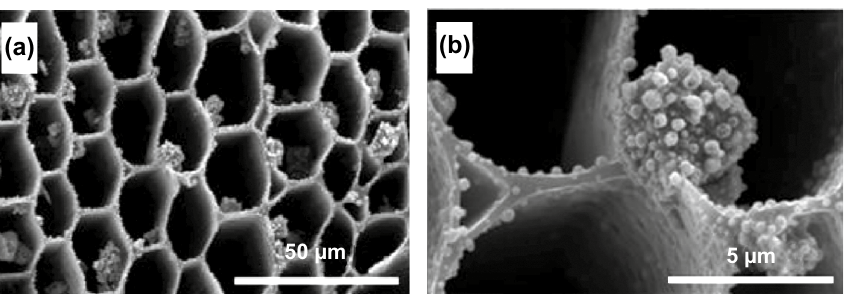
Fig. 2 SEM images of HKUST-1/3D-KSCs 800 at different magnifications, showing the growth of microporous HKUST-1 crystals on the 3D-KSCs 800 macroporous template. Reprinted with permission from Ref. [62]. Copyright 2018 Elsevier